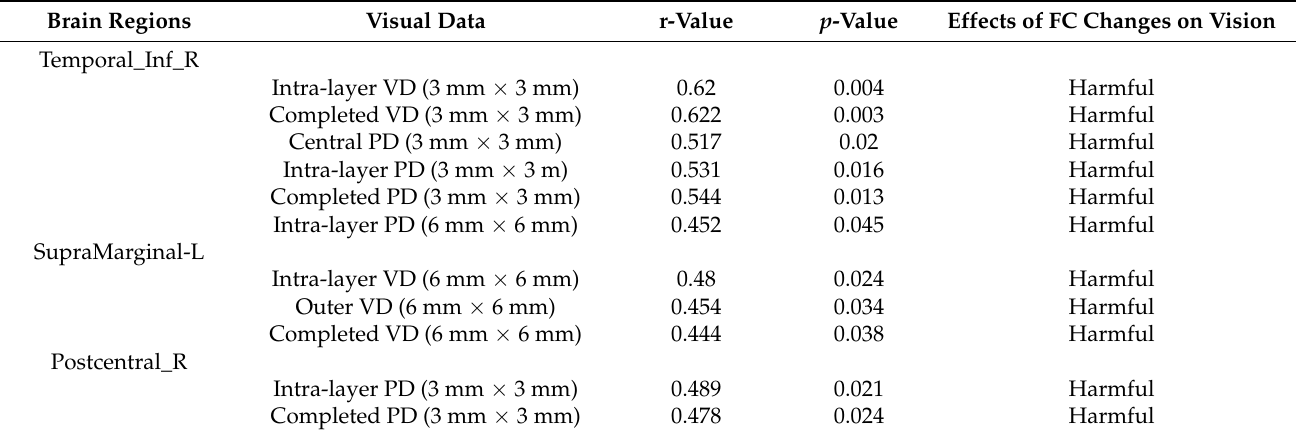
Table 4. Correlative analysis between FC changes and structural changes of the fundus of HC and CI subject.